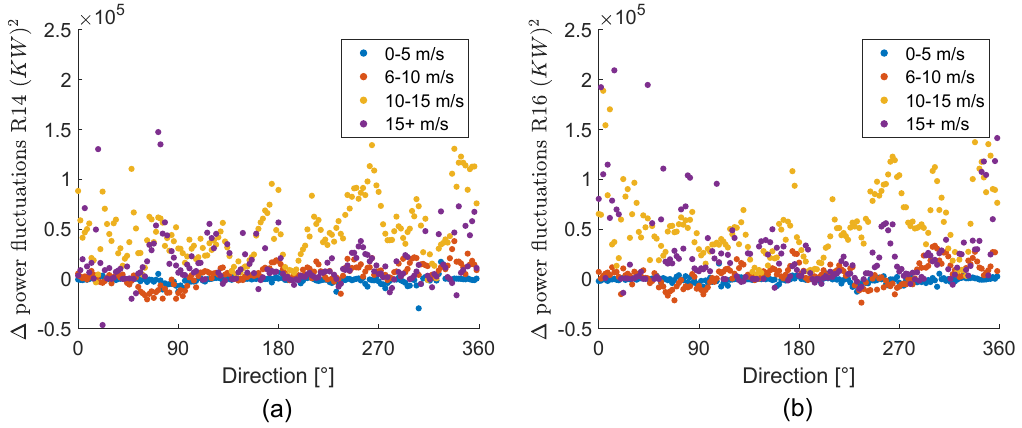
Figure 7. Difference of fluctuations characterized with respect to wind speed intervals for ( a ) R14 wind turbine and ( b ) R16 wind turbine.